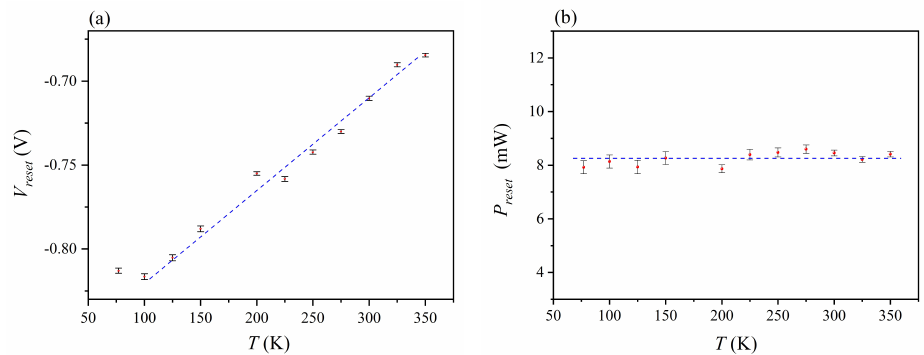
Figure 6. Reset voltage, V res , ( a ) and reset power, P res , ( b ) measured for the different temperatures. Each point corresponds to the mean value of 100 I–V cycles.